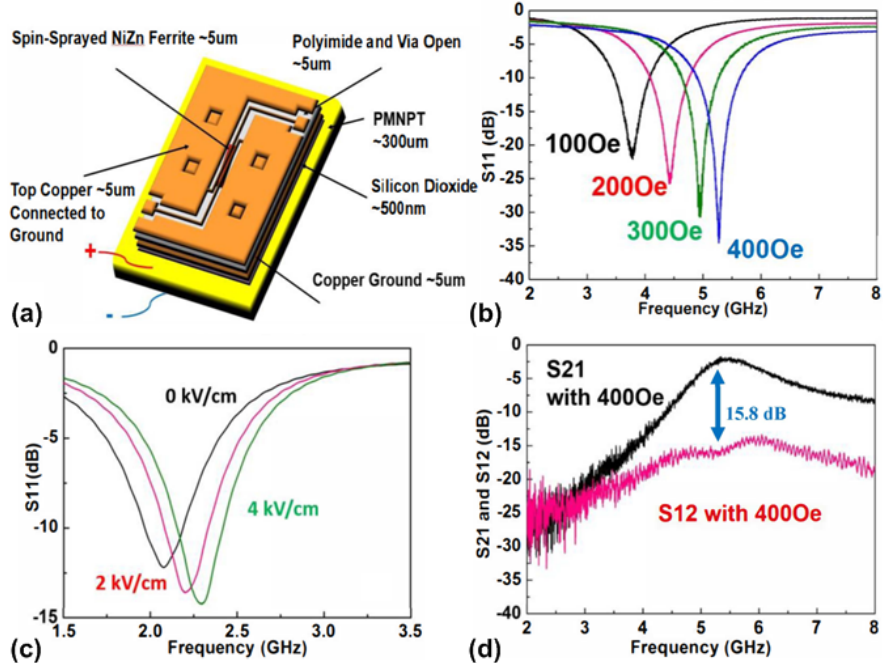
Figure 12. ( a ) Schematic of the tunable filter; ( b ) measured S 11 of the tunable filter as a function of the DC magnetic field; ( c ) measured S 11 of the tunable filter as a function of DC electric field across the thickness of the PMN-PT slab; and ( d ) measured S 21 and S 12 of the tunable filter at a magnetic bias field of 400 Oe. This figure is reproduced from [151] (© 2015 IEEE).